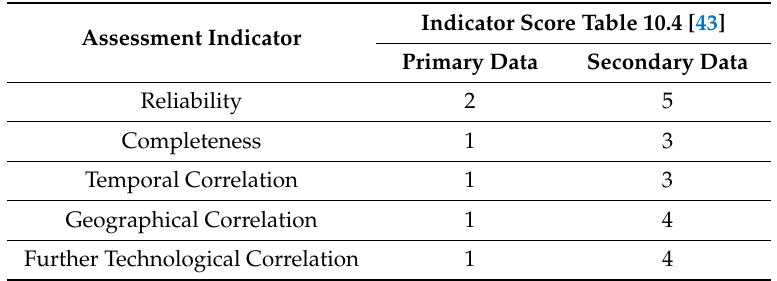
Table 3. LCI quality assessment.